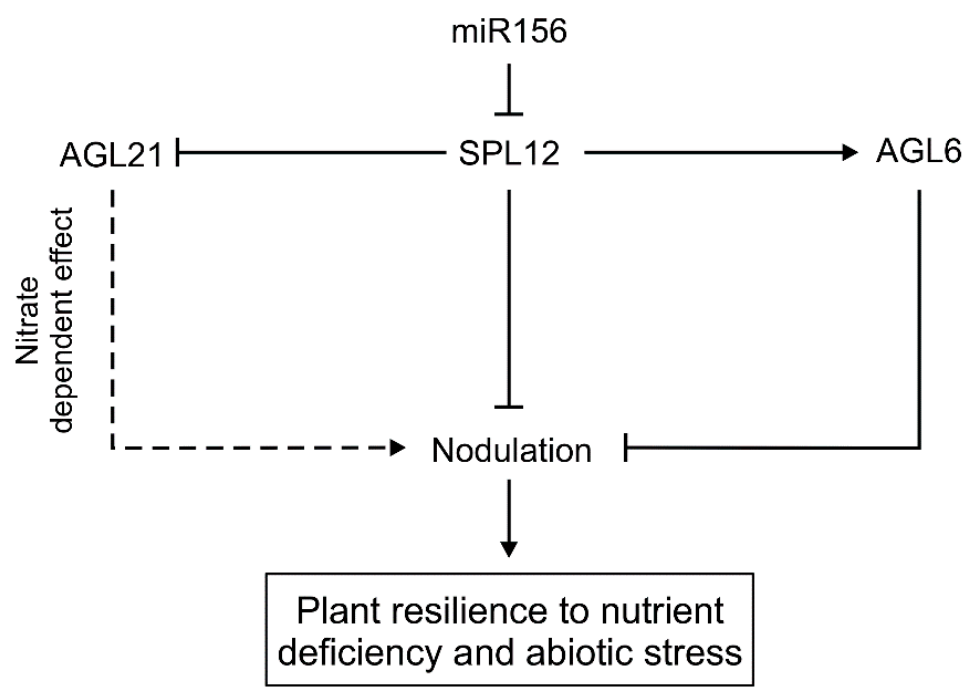
Figure 11. A model showing pathways for miR156/SPL12 regulation of nodulation in alfalfa. Solid lines or arrows indicate an experimentally confirmed mechanism, while dotted lines or arrows show a predicted pathway. Arrow heads indicate positive regulation while line heads indicate negative regulation.